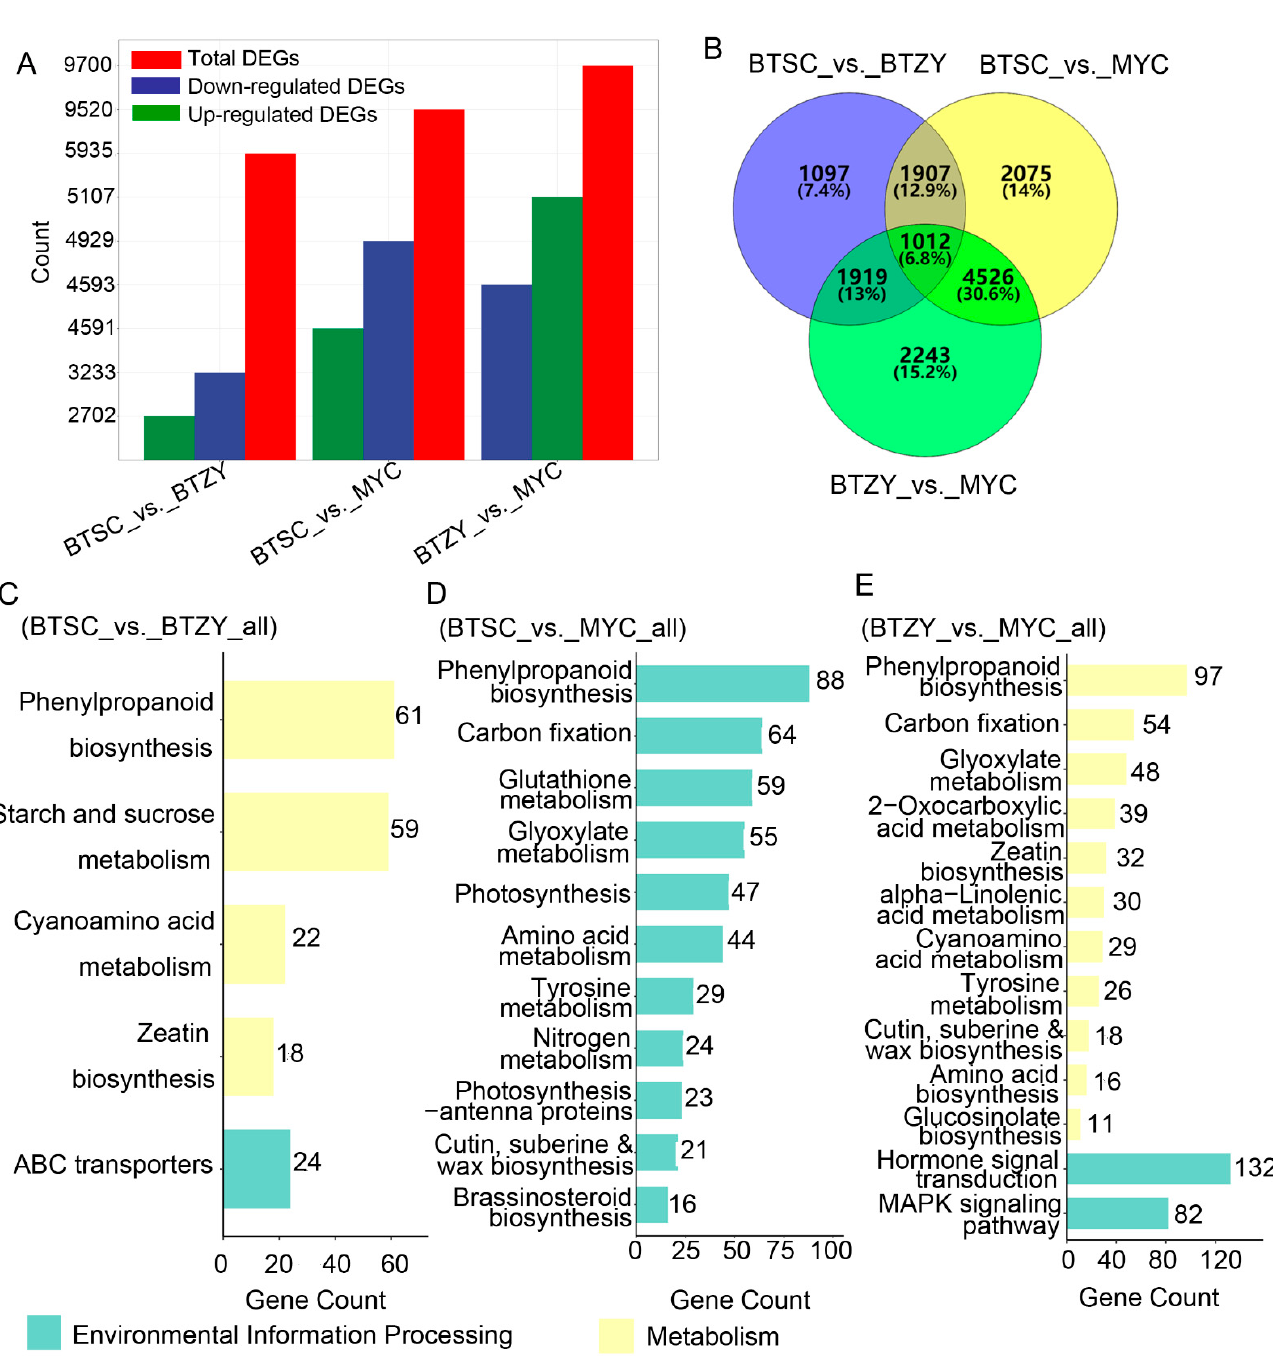
Figure 4. Identification of DEGs and KEGG enrichment in three groups. ( A ) Statistics of DEGs in three groups; ( B ) Venn diagram of DEGs in the three groups; ( C – E ) The main KEGG enrichment pathway of DEGs in three comparison groups.